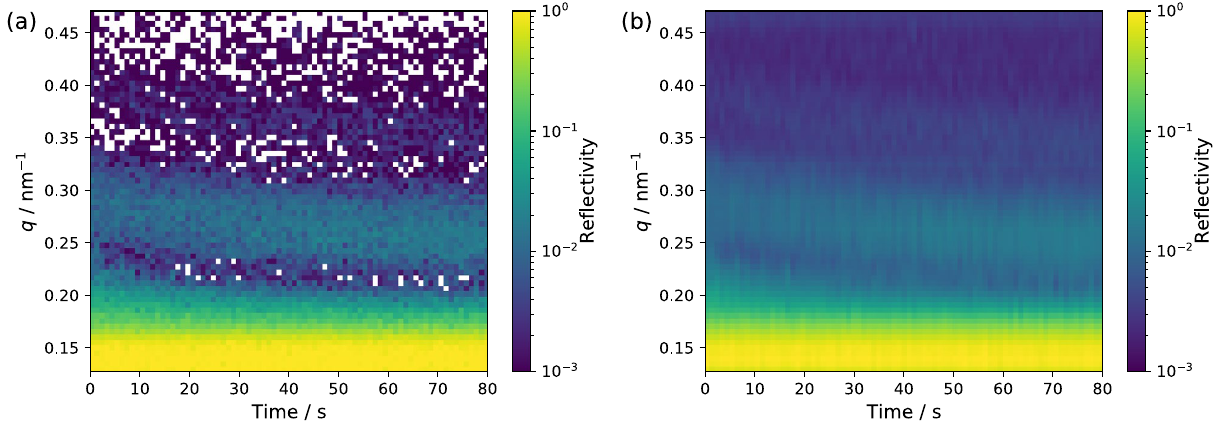
Figure 5. Raw ( a ) and deep learning-processed ( b ) time-dependent NR profiles for a 45-nm PVA film in heavy water. The neutron beam was incident from the substrate at an angle of 0.5 network in data